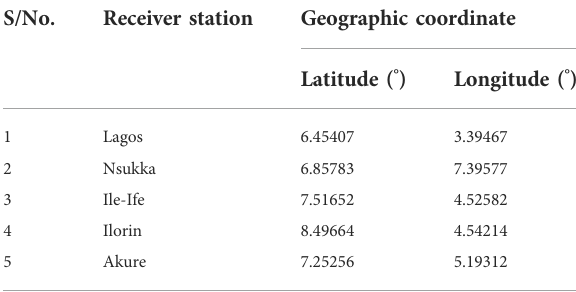
TABLE 2 GPS SCINDA receiver stations available in Nigeria.